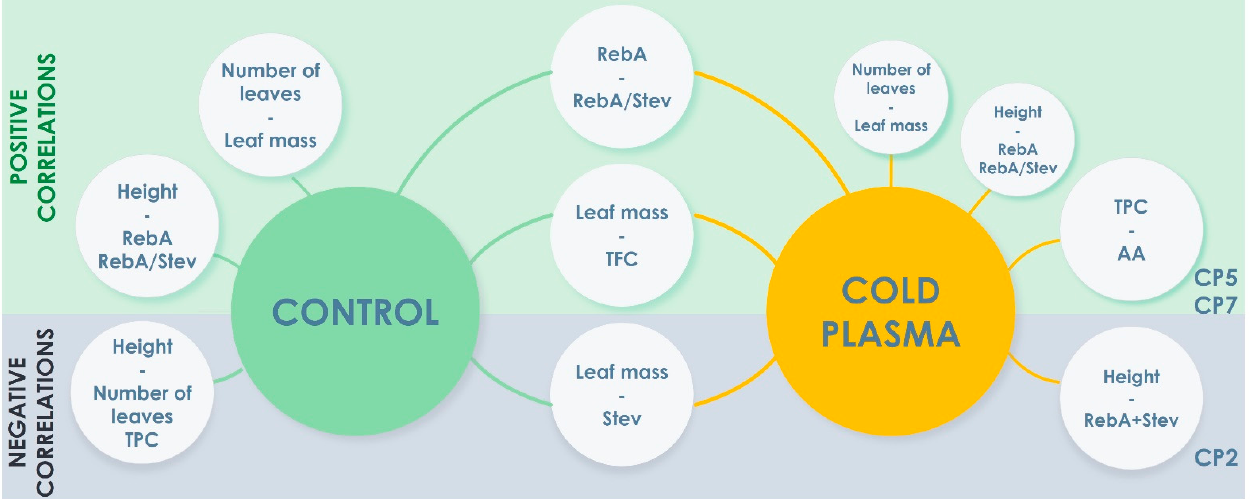
Figure 7. Schematic overview of CP-induced changes in correlations of variables deduced from PCA analysis. Smaller circles denote weaker correlations compared to control.